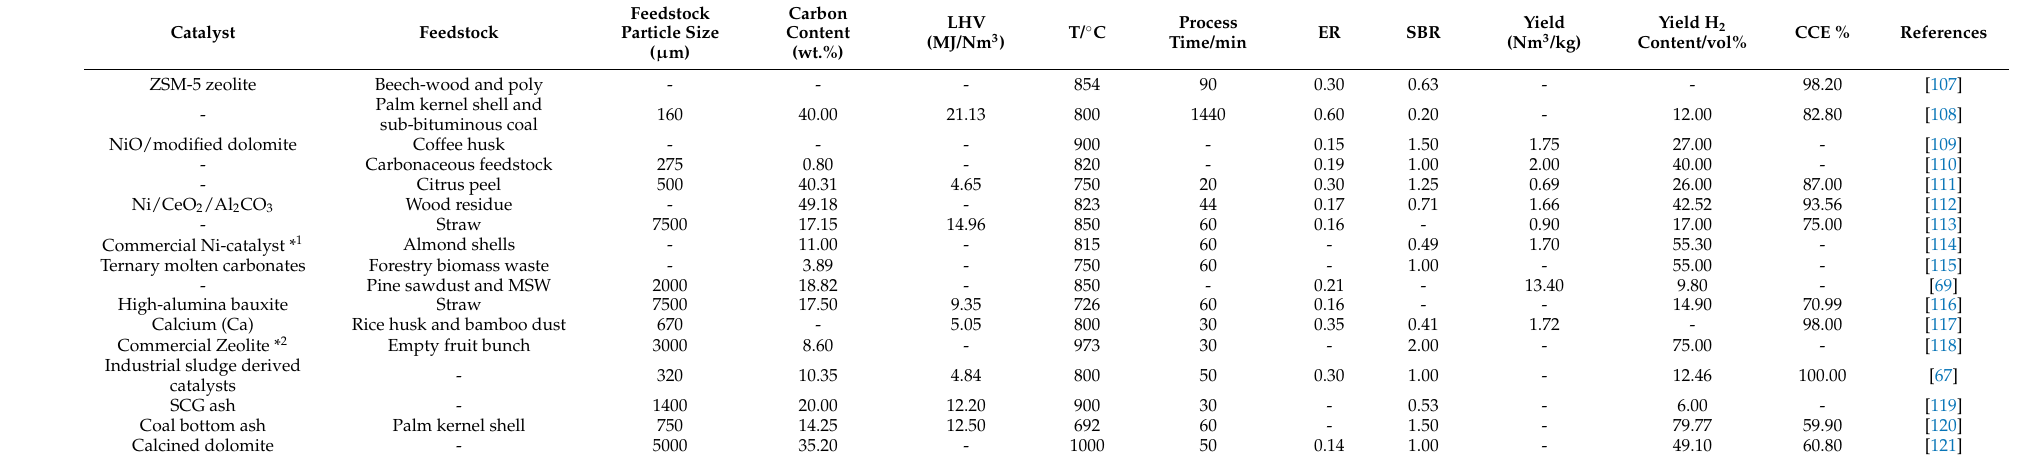
Table 4. Operational parameters of general fluidized bed (types not specified in literatures) versus corresponding hydrogen generation, where - represents the value that is not available from the literature (in this work, for easiness of data handling, the voids were replaced by the average reported